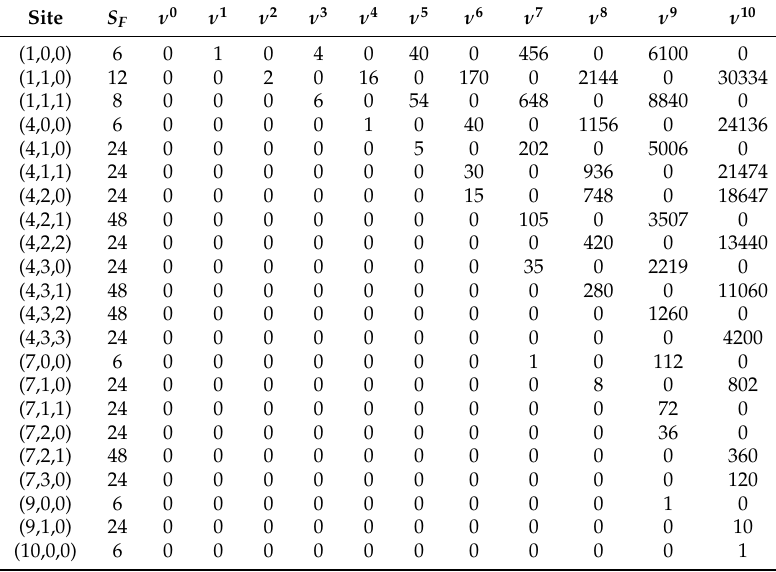
Table 1. The table shows the number of diagrams connecting the origin with the corresponding site. The second column lists the symmetry factor associated with each site on a cubic